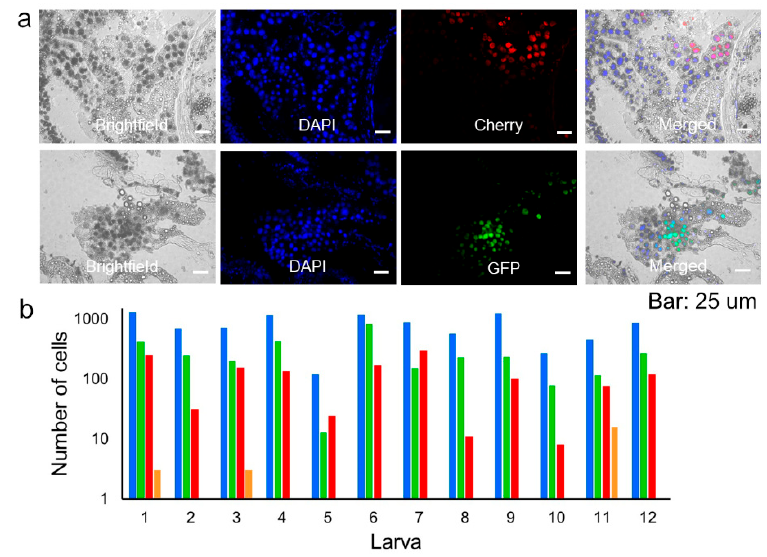
Figure 4. Analysis of variant mixing during late-stage infection. ( a ). Representative image of longitudinal sections of entire larvae inoculated with OBs from Sf21 cells coinfected with the GFP and Cherry variants (F1) obtained at 120 hpi. The phase contrast, DAPI, GFP, Cherry, and merged images are shown. Bars: 25 µ m. ( b ). Counts for DAPI-positive (blue), DAPI + GFP-positive (green), DAPI + Cherry-positive (red), and triply positive cells (orange) for five larvae.